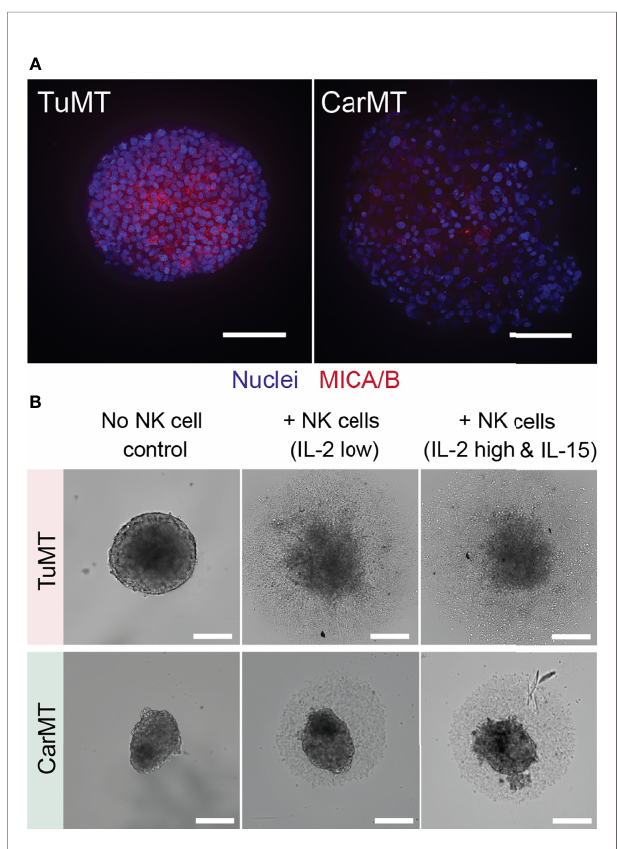
FIGURE 2 | (A) Membrane-bound MICA/B expression on TuMTs and CarMTs shown by maximum intensity projection of 100 m m-thick Z-stacks. Scale bars: 100 m m. (B) Speci fi c anti-tumor activity of UCB-derived NK cells in static co-cultures in a 96U-well plate. Upper panels: TuMT disintegrated after 72 hours in co-culture with NK cells. Lower panels: CarMT remained intact in co-cultures with UCB-derived NK cells. Scale bars: 200 m